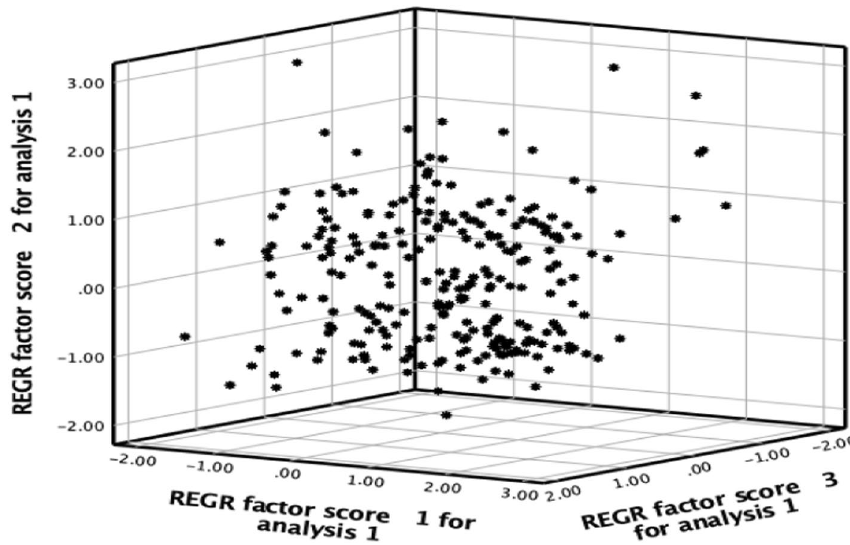
Fig. 3 Three-dimensional factor scores of farmers esti- mated by regression method